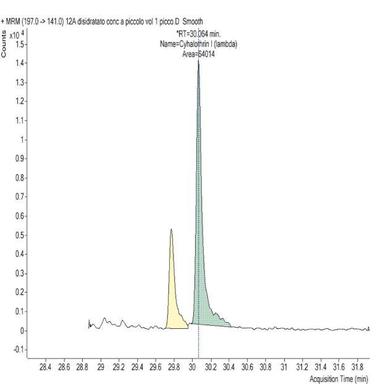
CS formulation: λ-Cyalothrin by GC-MS/MS in pristine form a) and 1st fraction eluted by AF4-FFF-MALS b).